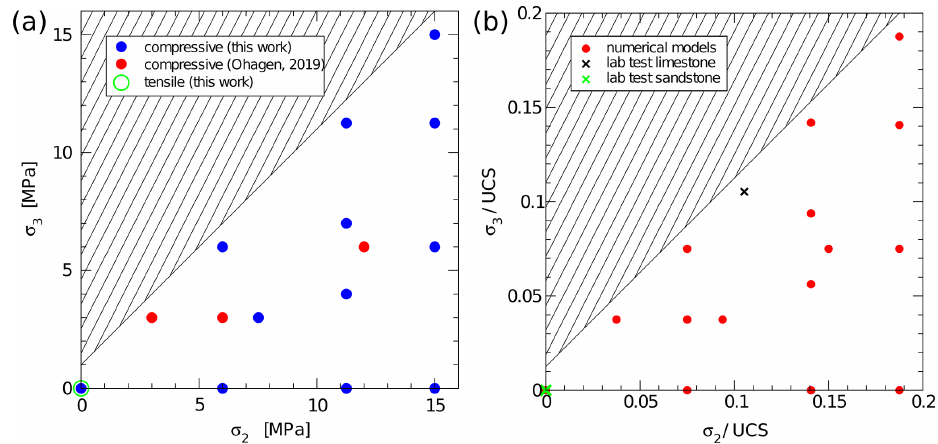
Figure 5. Confining stress range covered by the numerical models, combining the experiments in this work and the data from Ohagen (2019). (a) Numerical models only, using absolute stress values. (b) Numerical and laboratory experiments, using stress values scaled by the unconfined compressive strength of the respective material. Hatched segment in top left of the diagrams: parameter space excluded by the condition σ 3 ≤ σ 2